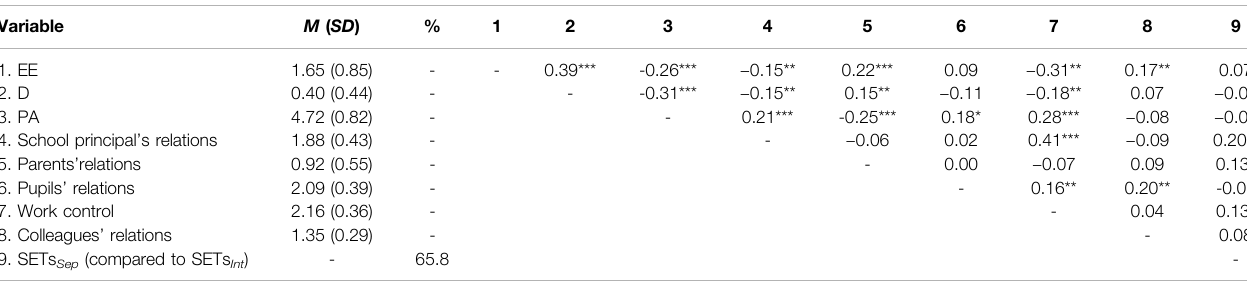
TABLE 10 | Correlations between variables used for hypotheses tests.